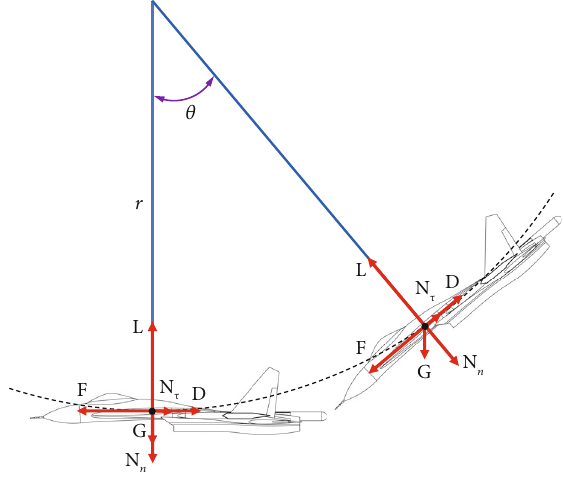
Figure 7: Force analysis diagram of aircraft.